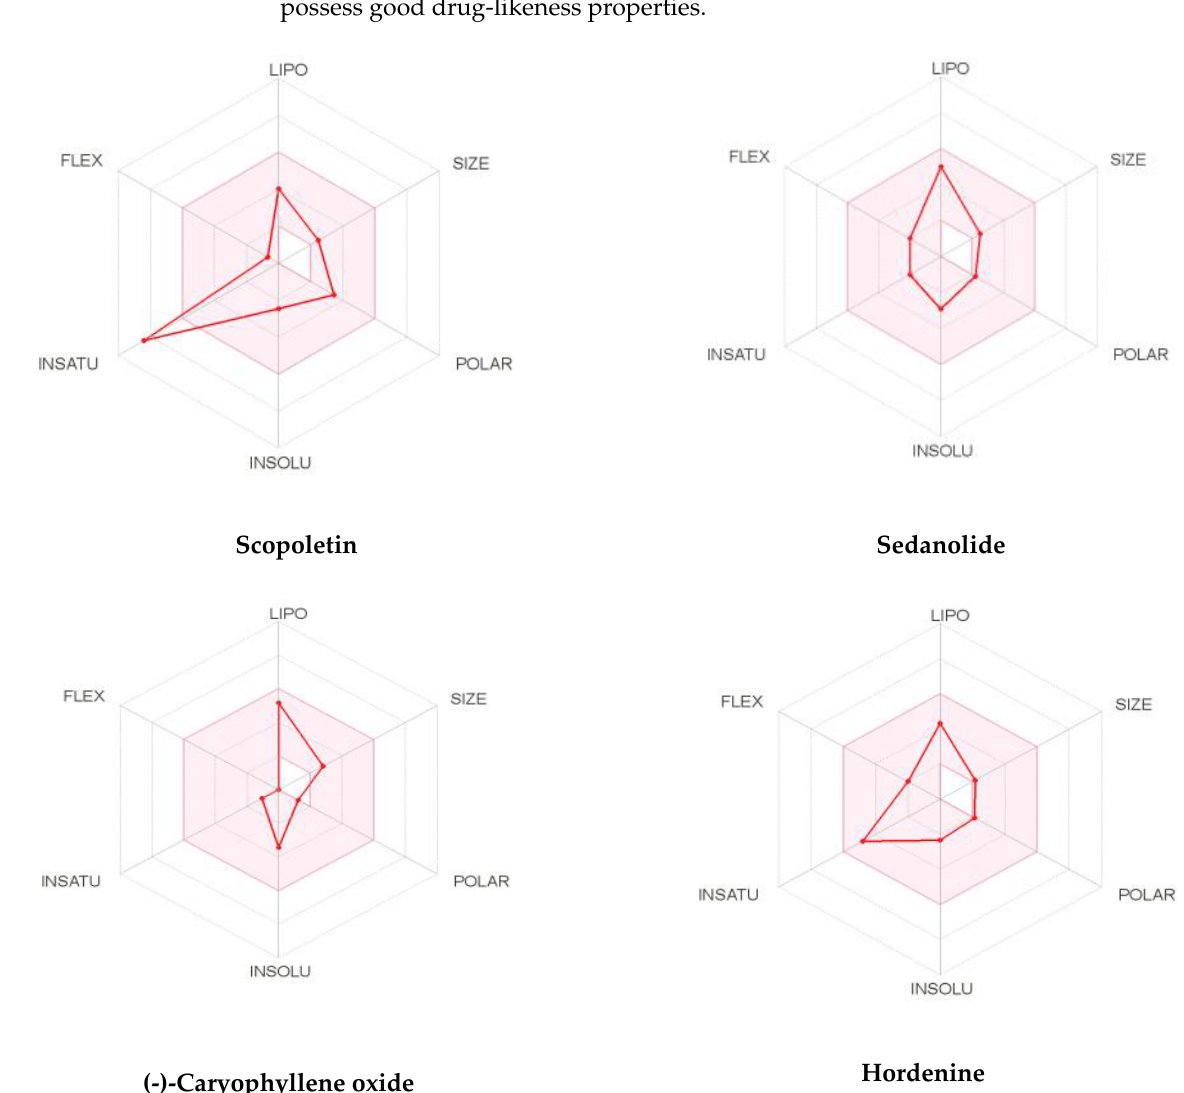
Figure 7. Top bioavailability radar of the phytocompounds based on physicochemical indices ideal for oral bioavailability.